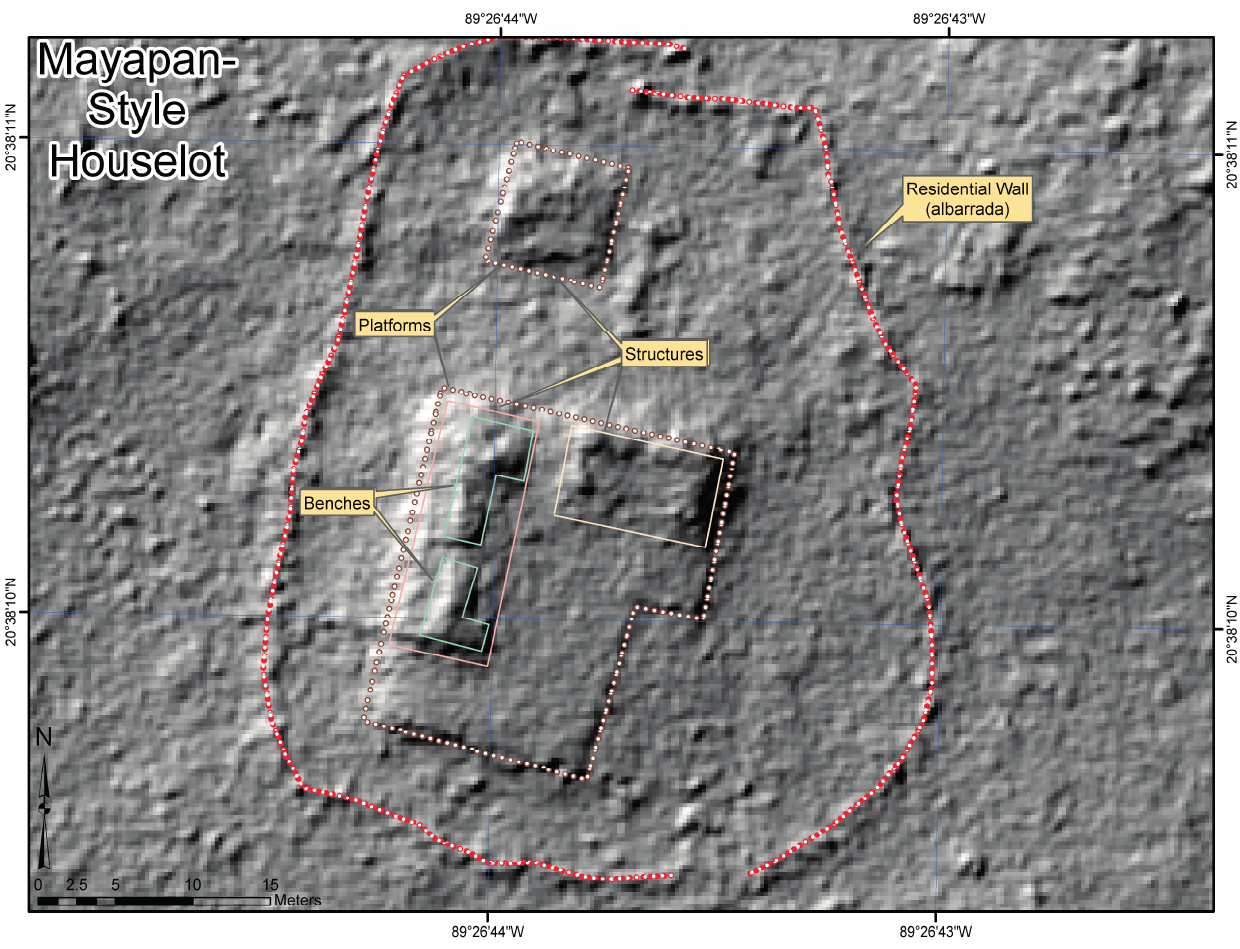
Figure 11. Example of a mapped solare or walled